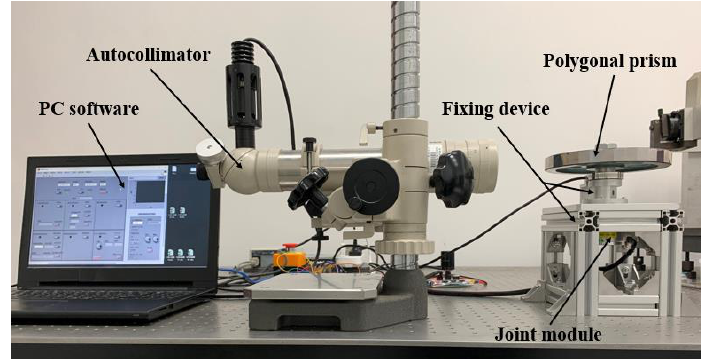
Figure 3. Experimental calibration platform.